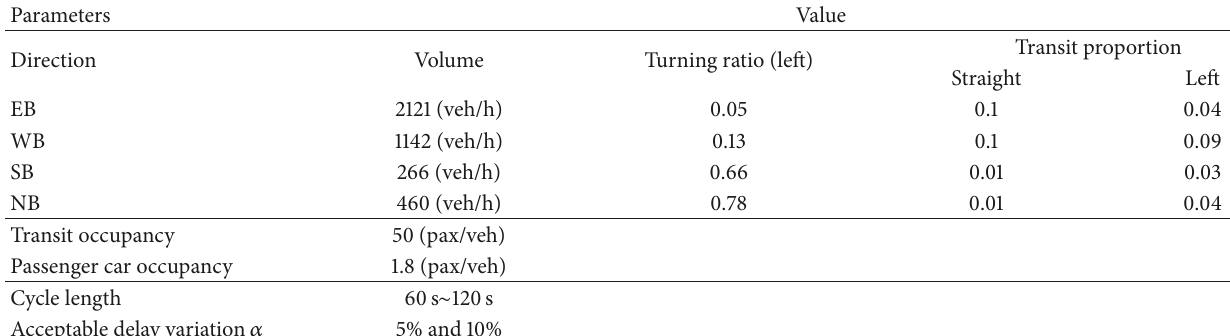
Figure 5: Study intersection. Table 1: Parameters of the traffic